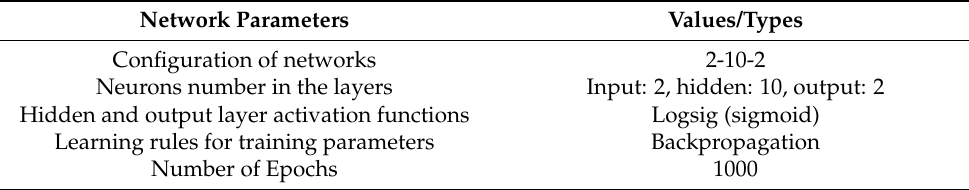
Table 3. Multilayer perceptron training and architecture parameters for this